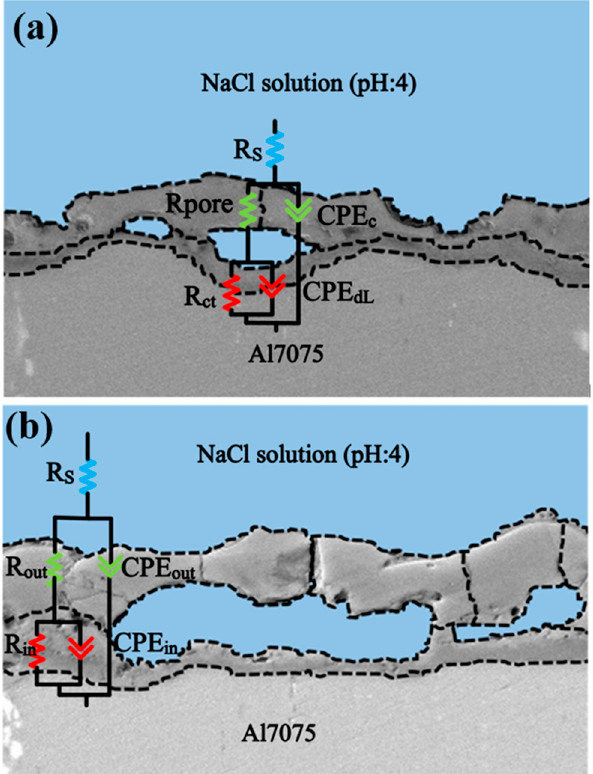
Figure 8. Equivalent circuits used for the impedance response fitting: ( a ) for S0K2 specimen, and ( b ) for S2K2, S3K2, S4K2, and S5K2 specimens. The corrosion behaviour of the S0K2 specimen is modelled using the EC in Figure